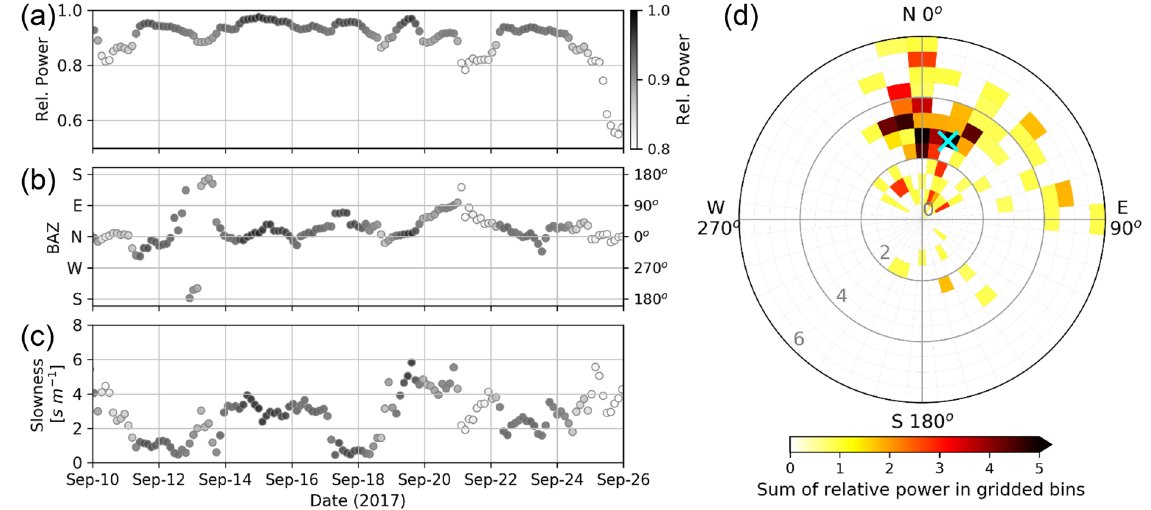
Figure 4. Directional phase propagation from data in Fig. 3b calculated using frequency-wavenumber (FK) analysis. Time series of ( a ) relative power, similar to goodness of waveform fits, ( b ) back azimuth (BAZ), and ( c ) slowness of propagation. ( d ) Polar plot of statistical BAZ and slowness (gray values in s m −1 ) with sum of relative power in gridded bins. Cyan cross shows the BAZ (data points in b ) and slowness (data points in c ) weighted average by the relative power (data points in a